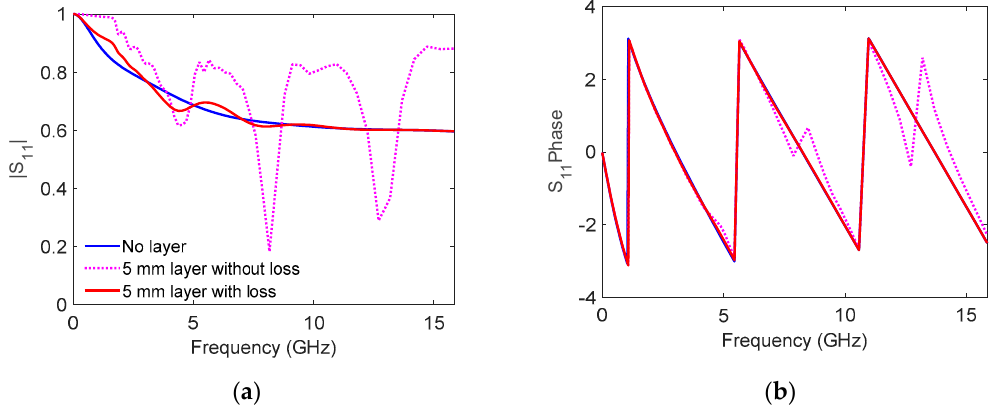
Figure 2. ( a ) Magnitude and ( b ) phase of simulated reflection coefficient for three water layers. Blue: Infinite thick layer. Red: 5 mm thick layer. Magenta: 5 mm thick layer, with water dielectric loss factor set to zero in the simulations.